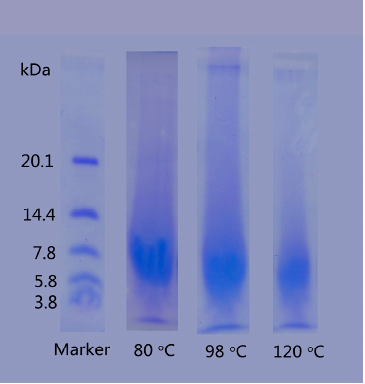
Figure 4. SDS-PAGE of regenerated keratins by dissolving in DES at various